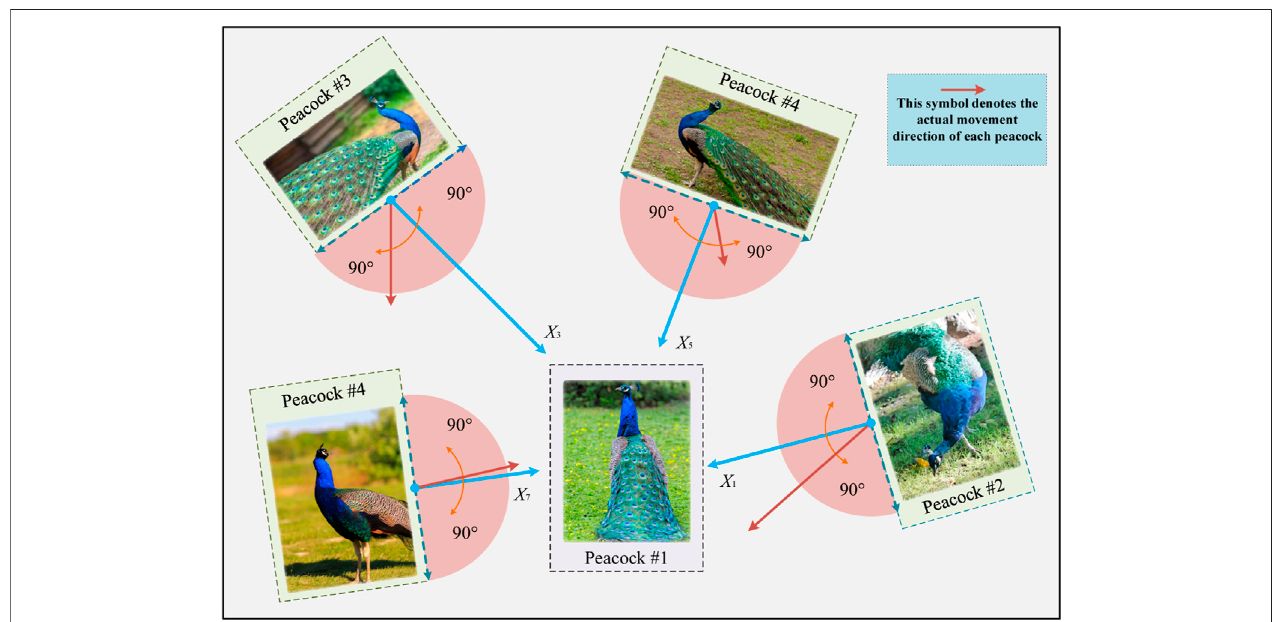
FIGURE 3 | Interaction mechanism among different